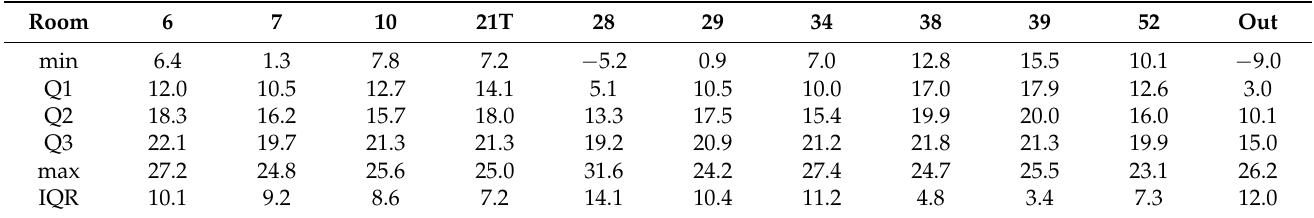
Table 2. Summary of the statistical parameters for temperature ( ◦ C) data over the period 1 June 2017, until 31 May 2018 (min = minimum; Q1 = first quartile; Q2 = second quartile or median; Q3 = third quartile; max = maximum; IQR = interquartile range).